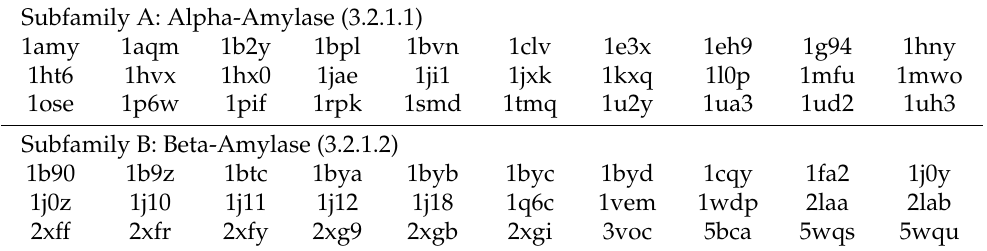
Table A1. Dataset: